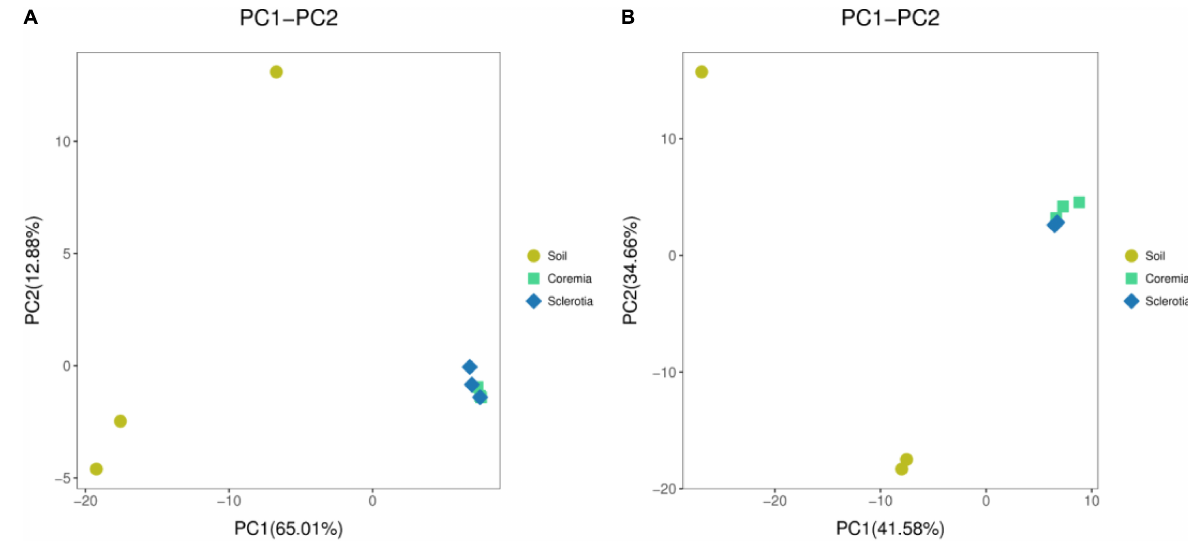
FIGURE 2 | Principal component analysis (PCA) of the (A) bacterial and (B) fungal communities in the samples of soil, coremia, and